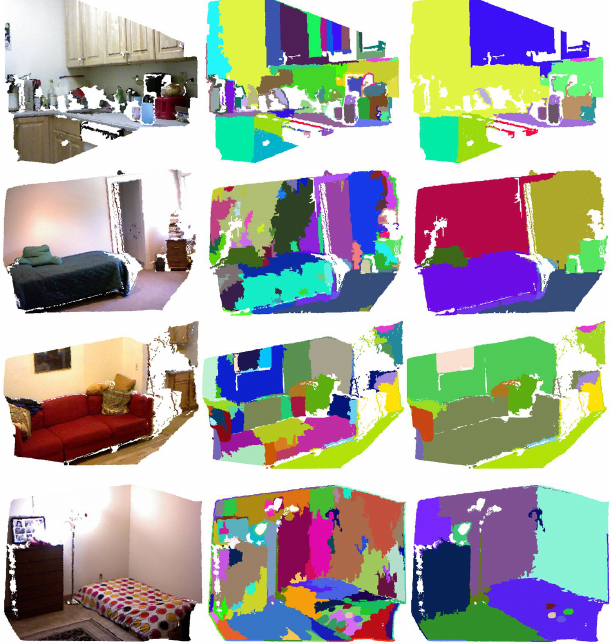
Figure 6: Segmentation examples (snapshots of 3D models): point clouds with color (left), patches/superpixels (middle) and the segmentation results